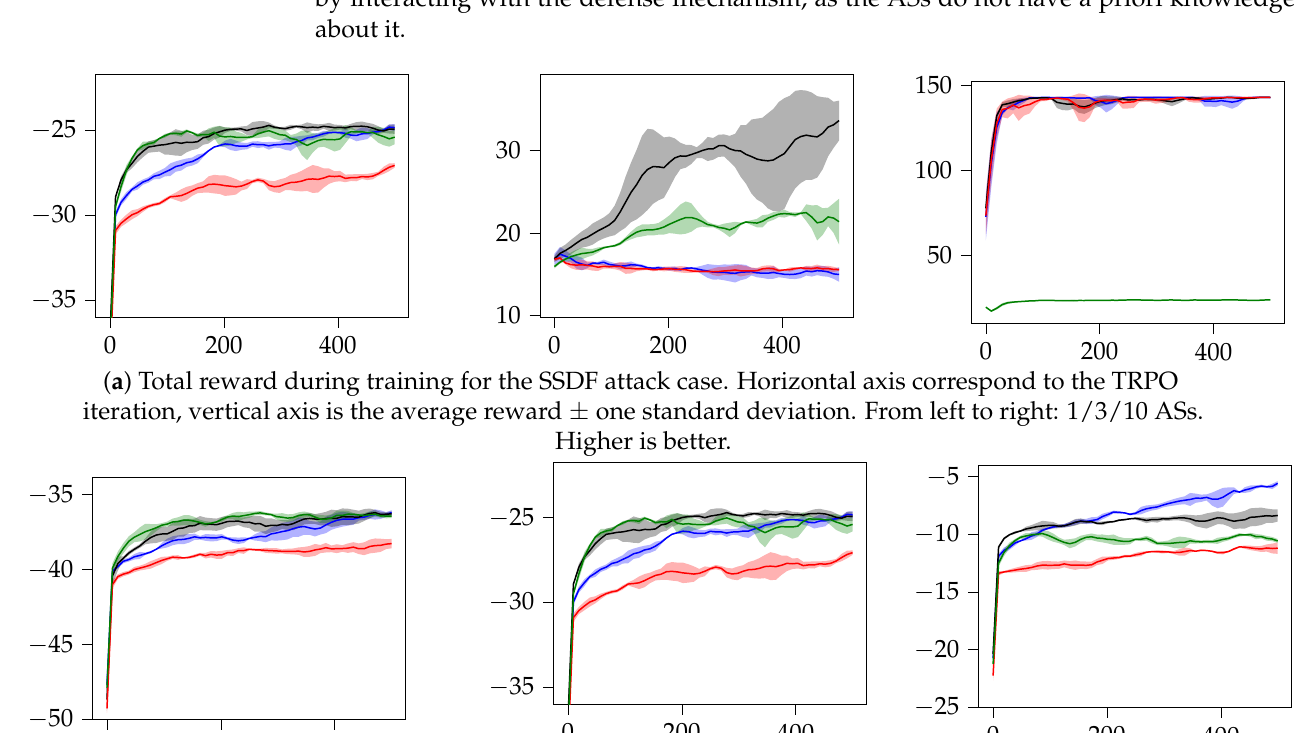
Figure 5. Training results for the SSDF and backoff attacks for the best three seeds. We observe that the variability between seeds is higher in the SSDF attack. Also, note how DLAs improve their reward as training progresses, and specifically, observe that they do so simply by interacting with the defense